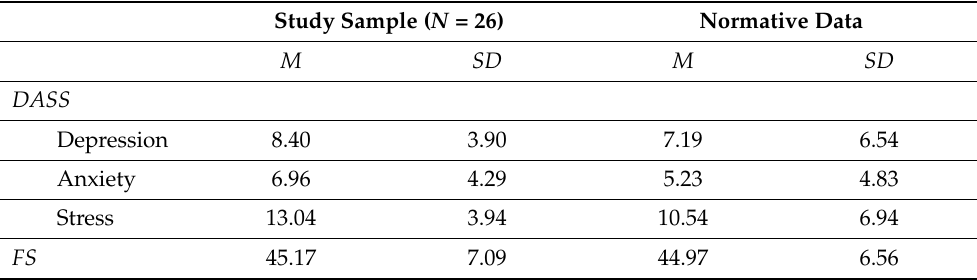
Table 1. Participant background measures (including means and standard deviations) and normative